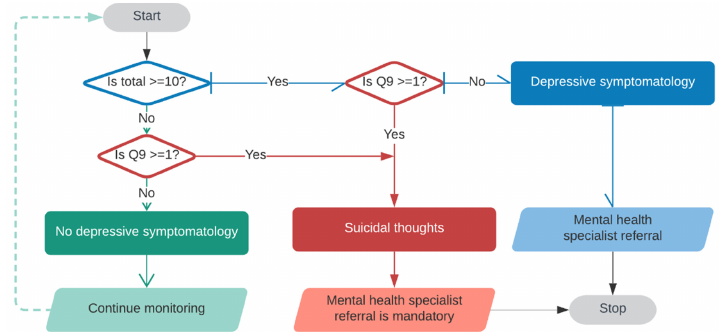
Figure 2. PHQ-9 algorithm for the fuzzy logic decision system.